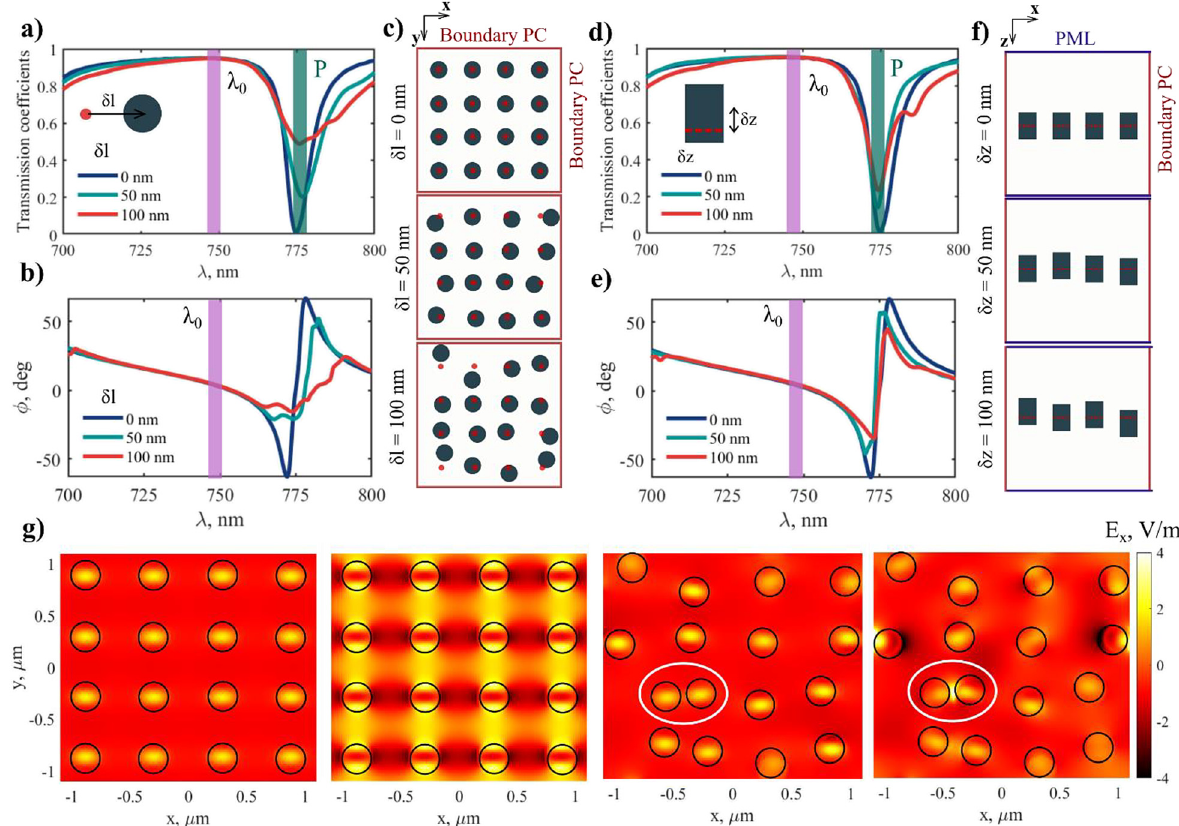
Figure 4: Numerical experiments demonstrating the resilience of HA metasurfaces to PD, paving the way toward disorder-immune meta- devices (geometrical parameters as in Figure 1). (a and b) Transmission and transmitted phase with different degrees of in-plane PD with standard deviation δ l , schematically depicted in (c), where the red dots indicate the ideal periodic array. (d and e) Transmission of the array with different degrees of out-of-plane PD, with standard deviation δ z , schematically depicted in (f). In the two cases studied, both trans- mission and phase in the HA regime are well preserved and remain almost invariant at λ 0 . (g) Calculated distributions of the x -component of the electric fi eld at λ 0 and point P indicated in (a) and (d). All fi elds are normalized to the same colorbar. From left to right, the fi rst two fi eld maps correspond to the periodic array at λ 0 and point P, respectively. The other two correspond to the same points for a PD given by δ l =100nm.Thewhitecircleshighlighttwocloselypackednanorodsexhibitingamarkedlydifferentbehavior;despitetheirproximity,at λ interparticle hotspot can be appreciated, while the dimer system at point P can be clearly seen to display strong near fi eld